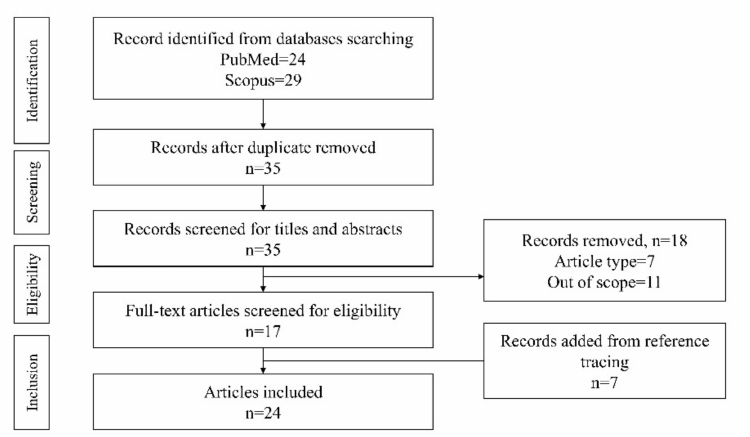
Figure 1. Article selection